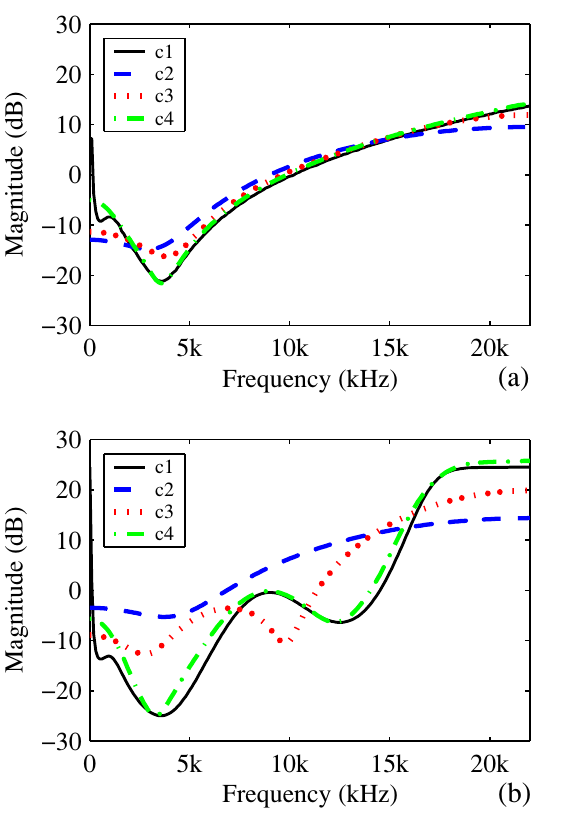
Figure 3. The design curves (c1) – modified E (a) and modified F (b) together with PSDs of the filters of 2 nd (c2), 5 th (c3) and 25 th (c4) order designed by the procedure II.